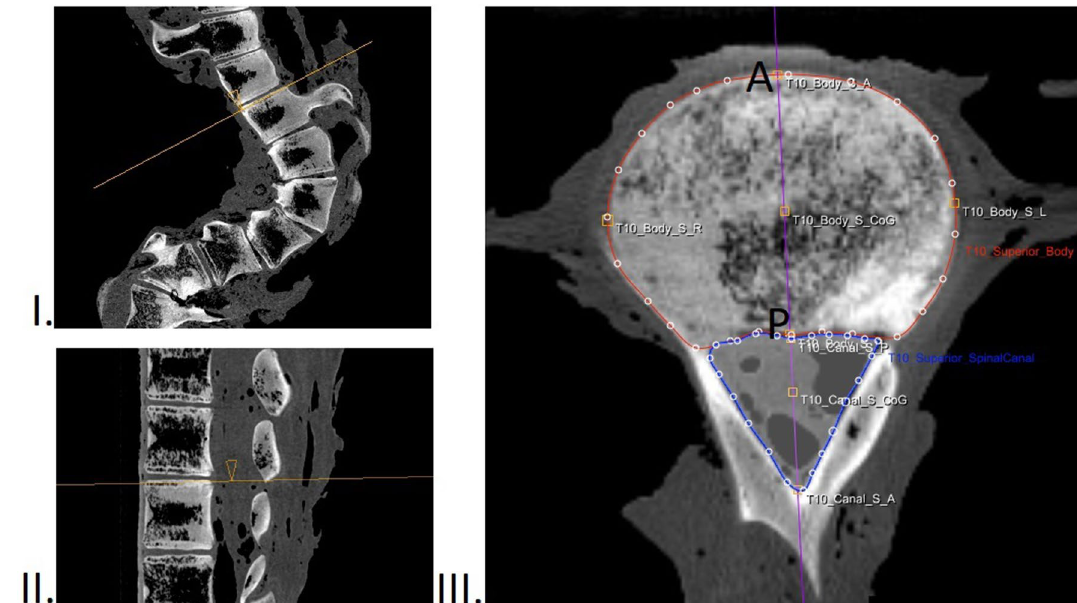
Figure 7. Method of 3D measurements on CT-scans in this study. For all upper and lower endplates, the observer adjusted the plane of view for coronal ( I ) and sagittal ( II ) tilt. In the true transverse plane, the vertebral body and spinal canal were manually segmented ( III ), whereafter the software automatically determined the 3D coordinates of the anterior (A) and posterior (P) point of the endplate, adjusted for rotation and deformity in all planes. The distances between these points were calculated to obtain the anterior and posterior heights of the vertebral bodies and intervertebral